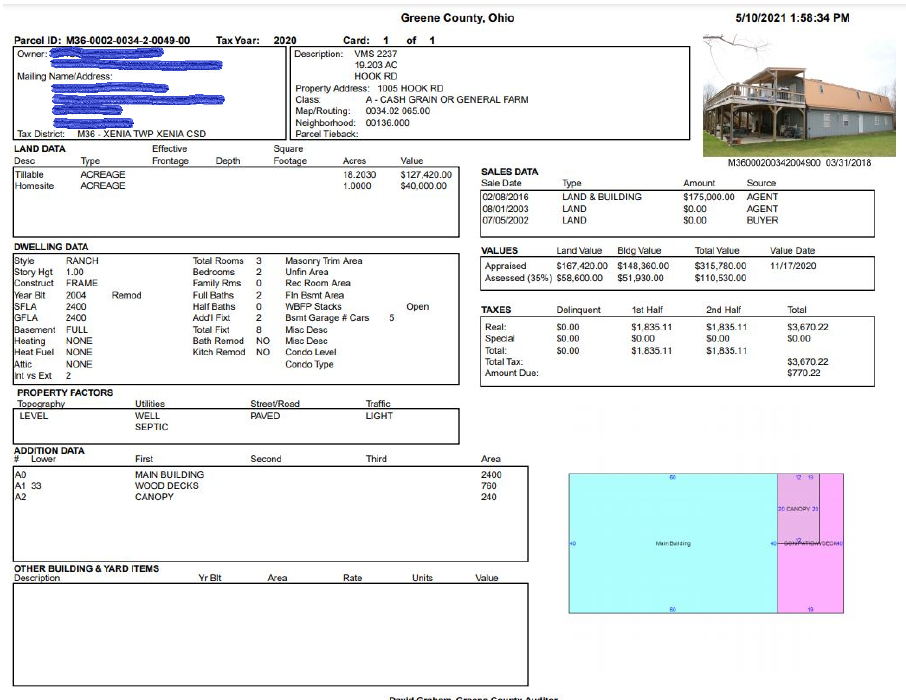
Figure 10. Property Card. Source: [35].